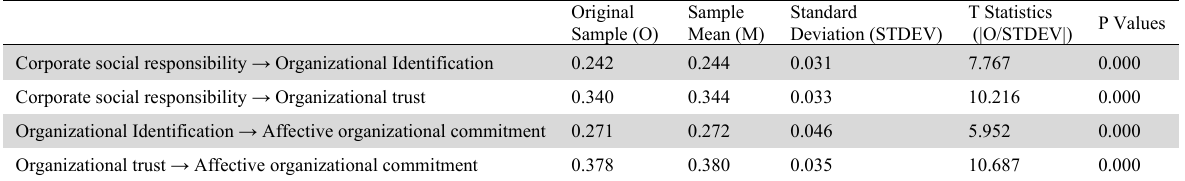
Path Coefficients (Mean, STDEV, T-Values, P-Values)